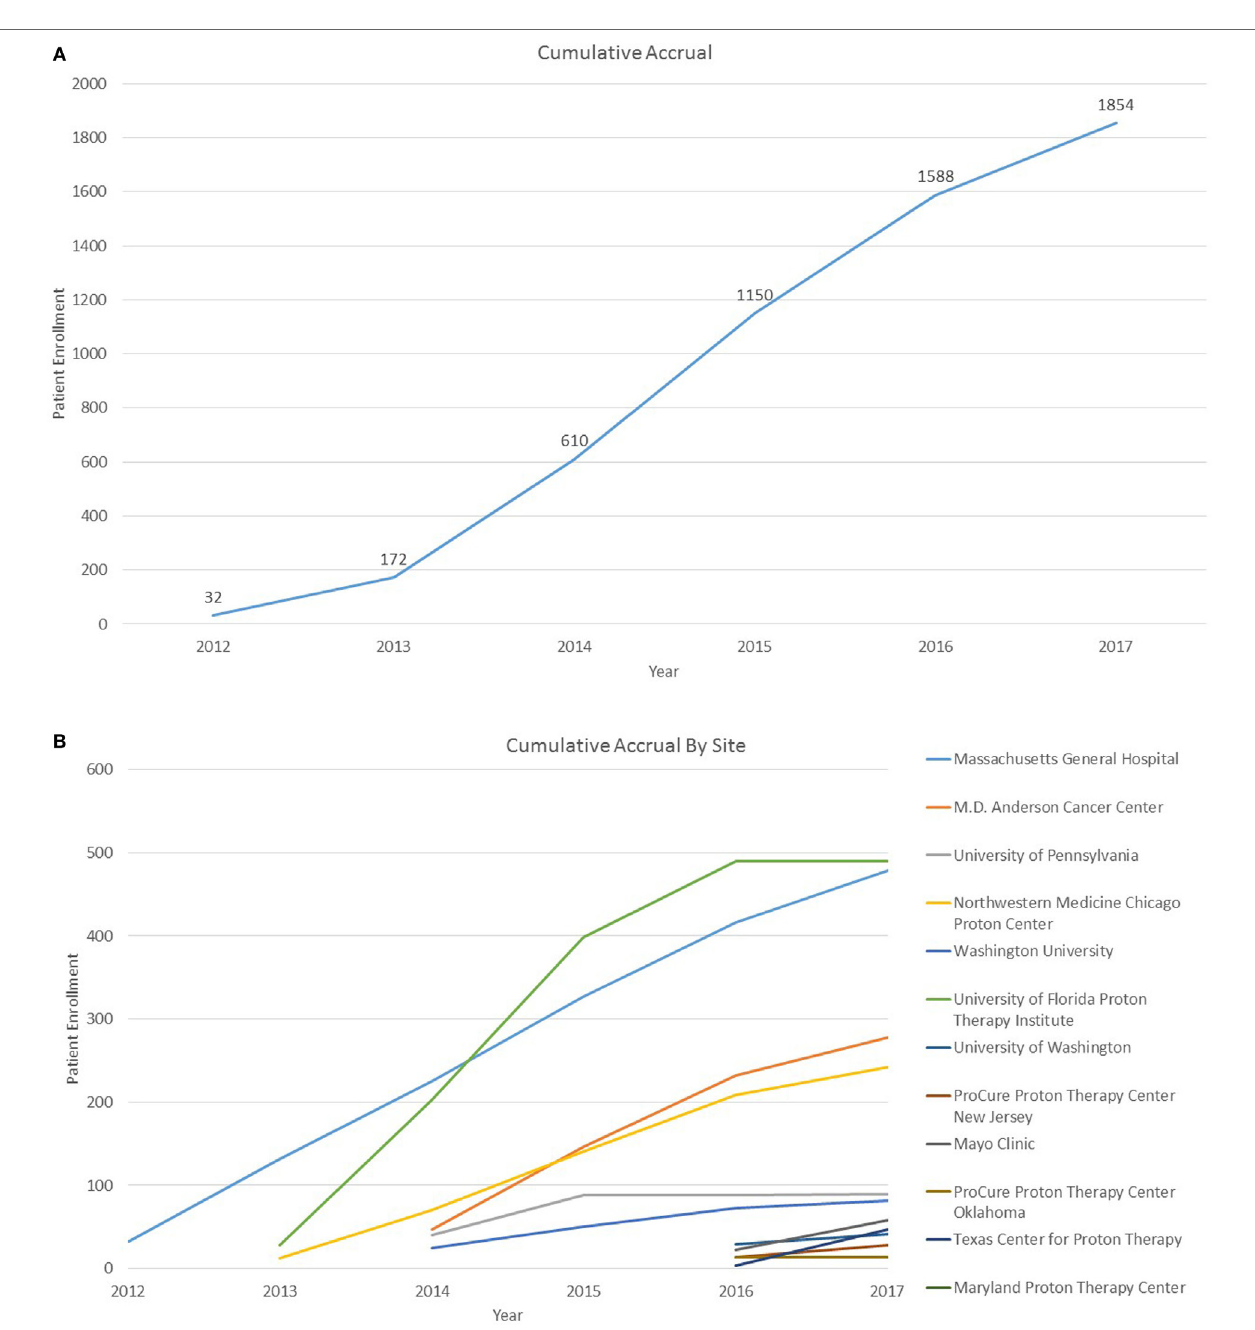
FigUre 2 | (a) Cumulative Pediatric Proton Consortium Registry (PPCR) accrual across all sites. Accrual represents enrollment by date of consent and may be larger than total participants within the database at time of analysis. (B) Cumulative PPCR accrual by